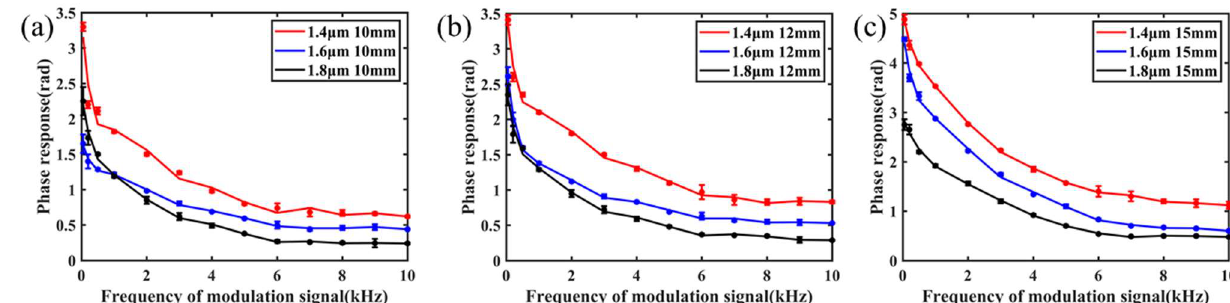
Figure 6. Frequency response of the OM phase modulator with different structural parameters; the lengths are the same as ( a ) 10 mm, ( b ) 12 mm, and ( c ) 15 mm.